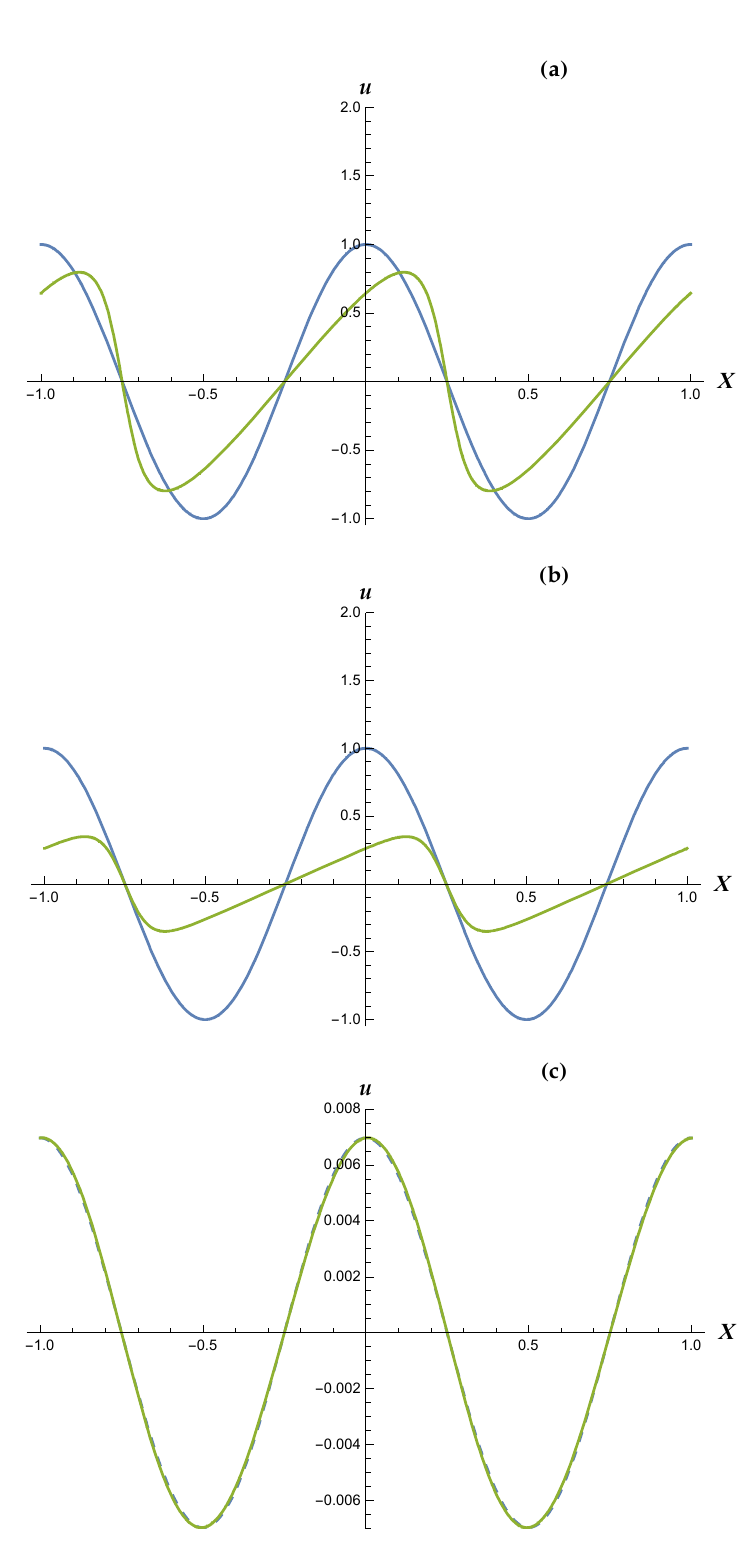
Figure 3. The damped Burgers equation case of IBVP (30). ( a – c ) correspond to T = T ∗ 20 T ∗ , respectively, where T ∗ B and α (cid:63) = 0.5. Blue curves (solid): IC given in Equation (30c). Blue-broken curve: u 2 ( X ,20 T ∗ (see Equation (31)), where we have set of trial-and-error “visual